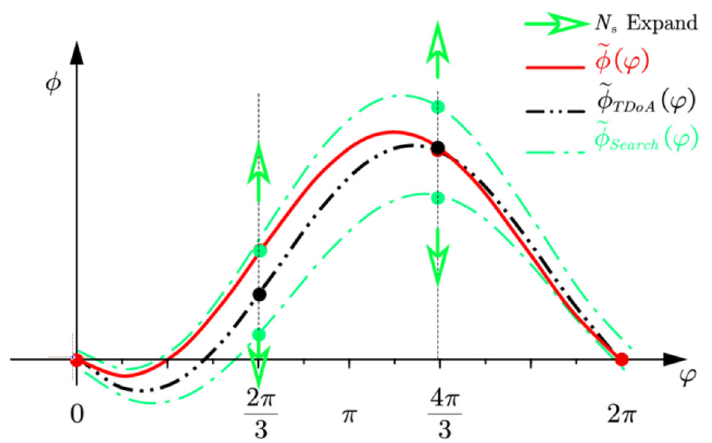
Figure 6. Variable neighborhood